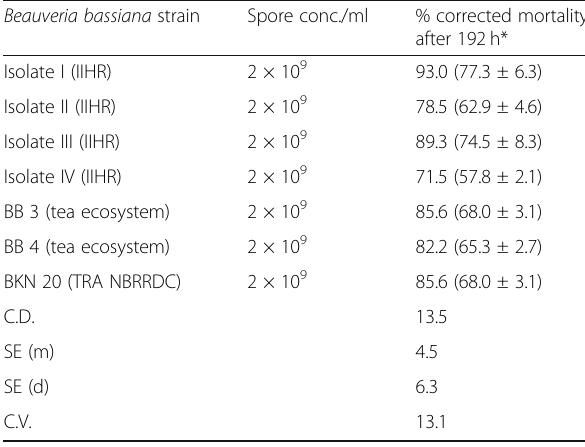
Table 2 In vitro bioassay of Beauveria bassiana isolates against